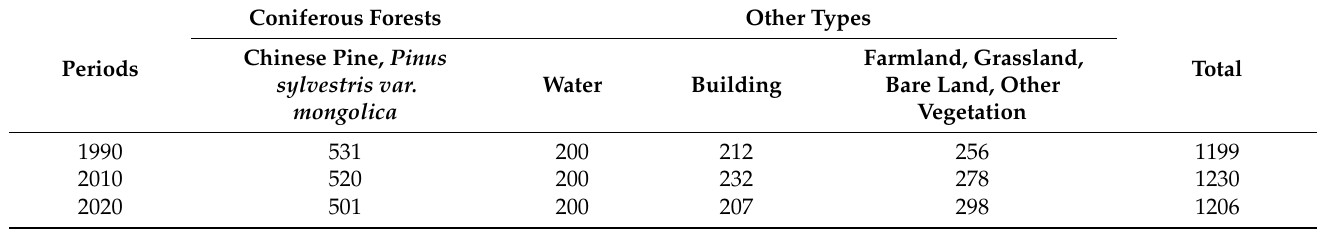
Figure 5. The spatial distribution of the test sample points in 2020. The red points are sample points of non-coniferous forests and the green ones are sample points of coniferous forests. Table 3. The detailed information of the test sample points. Sample points in three periods (1990, 2010 and 2020) were collected.